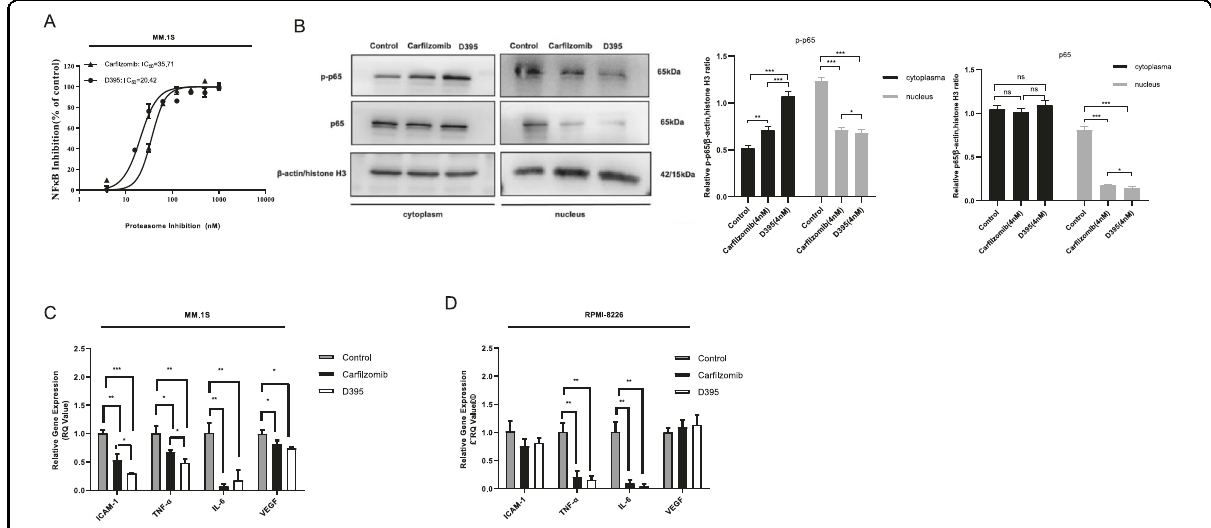
Fig. 4 D395 modulates the NF- κ B signaling pathway in MM cell lines. A HEK293T cells transfected with NF- κ B/luciferase were incubated with increasing concentrations of D395 or car fi lzomib for 6 h followed by 10 ng/ml TNF- α stimulation for another 18 h. Luciferase activity was determined by using the Dual-Luciferase Reporter Assay System. B RPMI-8226 cells were treated with D395 (4 nM) or car fi lzomib (4 nM). After 24 h, cytoplasmic and nuclear proteins were isolated for western blot using anti-p-p65 and anti-p65 antibodies. C , D RPMI-8226 and MM.1S cells were treated with the indicated concentrations of D395 or car fi lzomib for 24 h. Cell lysates were harvested, and total RNA was isolated. The expression of ICAM-1, TNF- α , IL-6, and VEGF was detected by qRT-PCR.